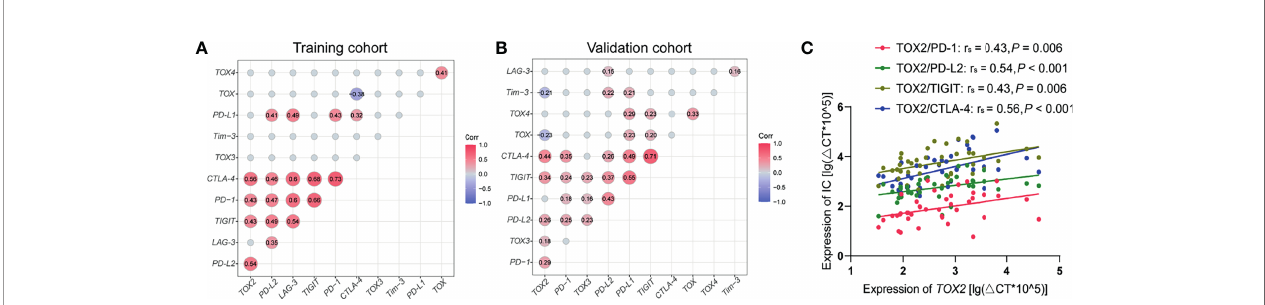
FIGURE 5 | Correlation between TOX and IC genes in peripheral blood from AML patients. (A) Correlation matrix heatmap showing the relationship between TOX and IC genes from training (A) and validation (B) cohort. Correlated genes ( P < 0.05) are displayed in red (positive correlation) or blue (negative correlation), and the degree of correlation is represented by the number in the middle of the circle and the shade of the color. (B) Correlations between the expression levels of TOX2 and that of PD-1 (red), PD-L2 (green), TIGIT (brown), and CTLA-4 (blue) from training cohort (C) . IC,